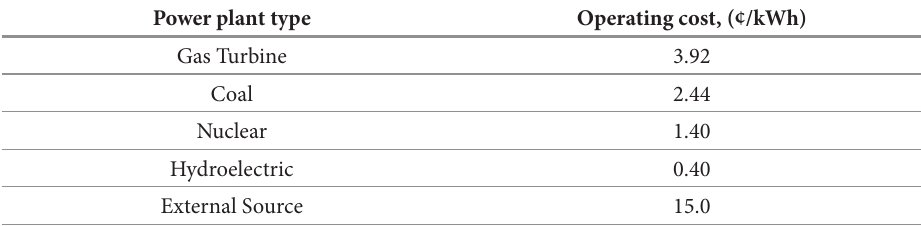
Table 3. Power generation operating costs